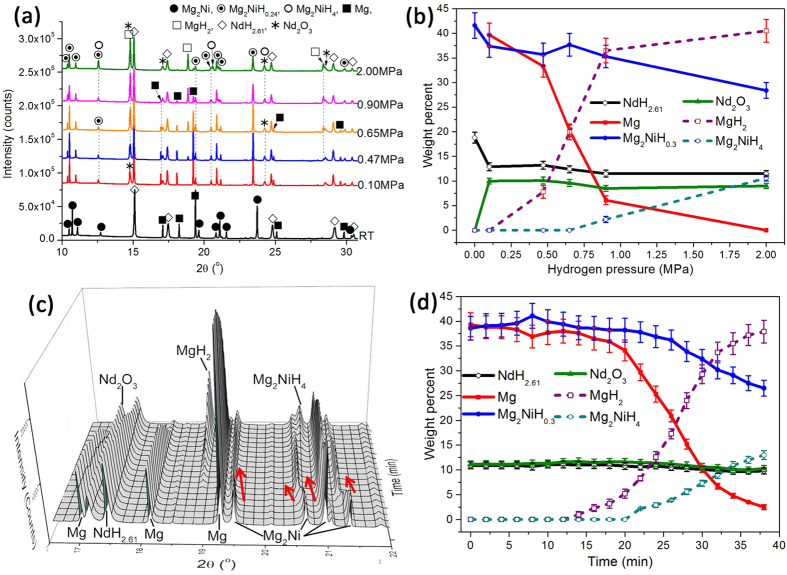
(a) The SR-PXRD patterns of NdH2.61-Mg-Mg2Ni composites under different hydrogen pressures at 350 °C, (b) the weight fraction of each phase versus pressure, (c) the SR-PXRD patterns of NdH2.61-Mg-Mg2Ni composites during hydriding process at different time at 300 °C, and (d) the weight fraction of each phase versus time.